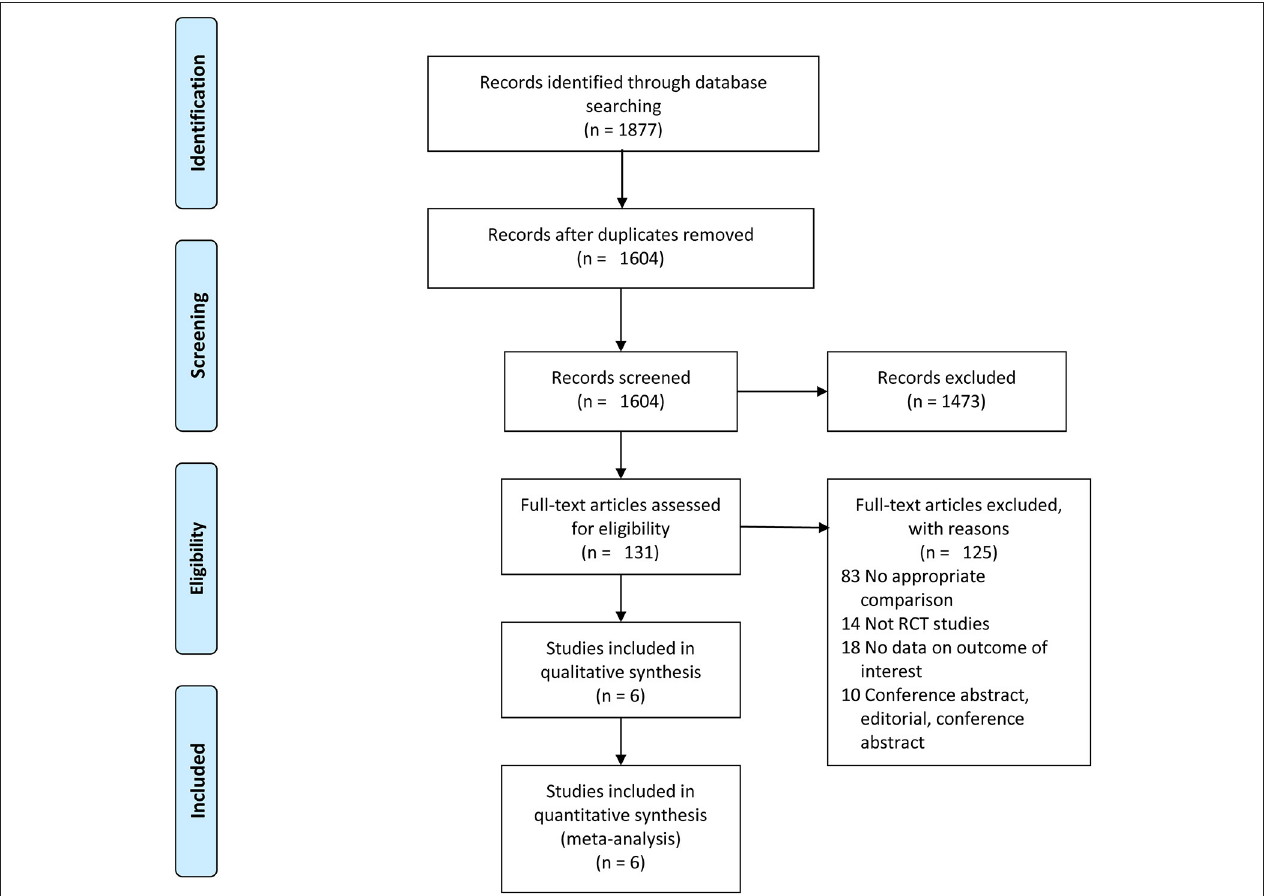
FIGURE 1 | Flow diagram of the study